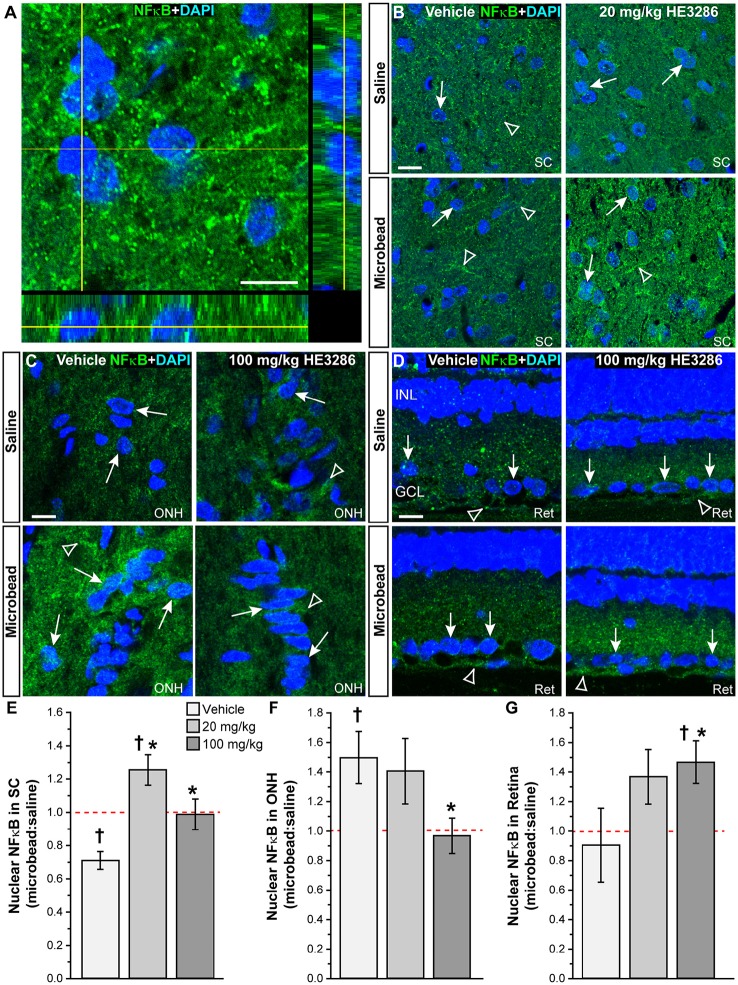
HE3286 modulates NFκB nuclear localization in the optic projection. (A) Confocal micrograph of a coronal section through naïve rat SC shows localization of NFκB (green) both outside and within DAPI-labeled nuclei (blue). Lines indicate location of orthogonal rotations through nuclei. Scale: 10 μm. Representative images (single optical plane) of superior colliculus (SC, B), optic nerve head (ONH, C) and retina (Ret, D) from vehicle and HE3286 rats shows localization of NFκB (green) both within (arrows) and external to (arrowhead) DAPI-stained nuclei. INL: inner nuclear layer of retina; GCL: ganglion cell layer. Scale: 10 μm. Bar graphs show nuclear localization of NFκB in SC (E), optic nerve head (ONH, F), and retina (G) expressed as the ratio of microbead:saline in vehicle and HE3286 treated tissue; ratio of 1, or unity, indicated by dotted line. †Indicates significant departure from expected ratio of unity (p ≤ 0.026). *Indicates p ≤ 0.044 compared to ratio for vehicle group. n = 5 animals per treatment group.